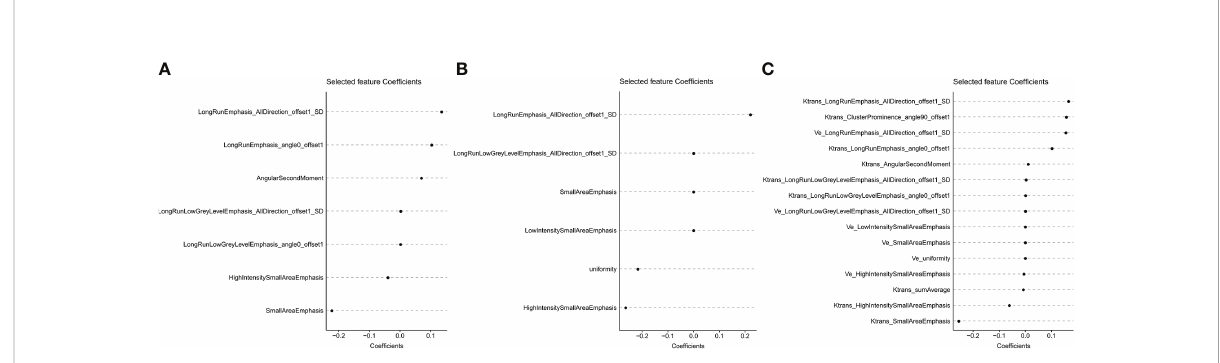
FIGURE 3 The x- and y-axes show the features and their coef fi cients, respectively. Finally, the 7, 6, and 15 features with non-zero coef fi cients were extracted from K trans (A) , V e (B) , and K trans + V e (C) images,